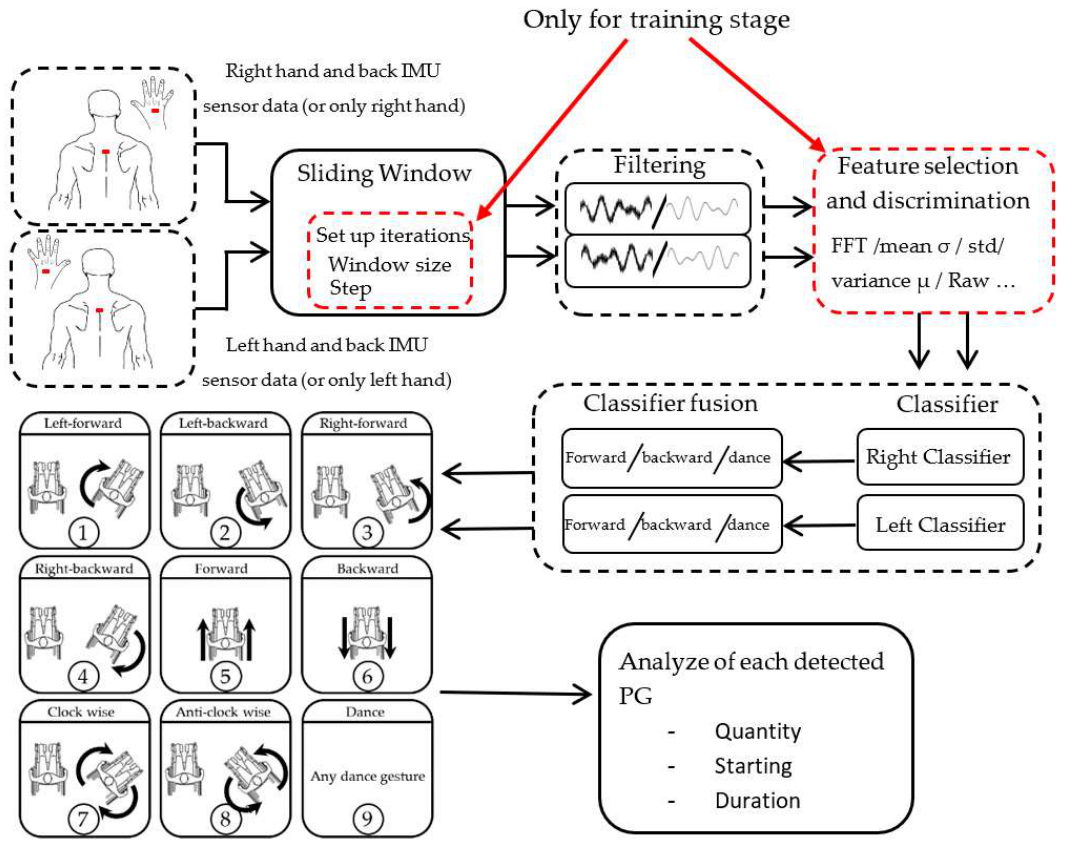
Figure 4. Algorithm structure of WISP.